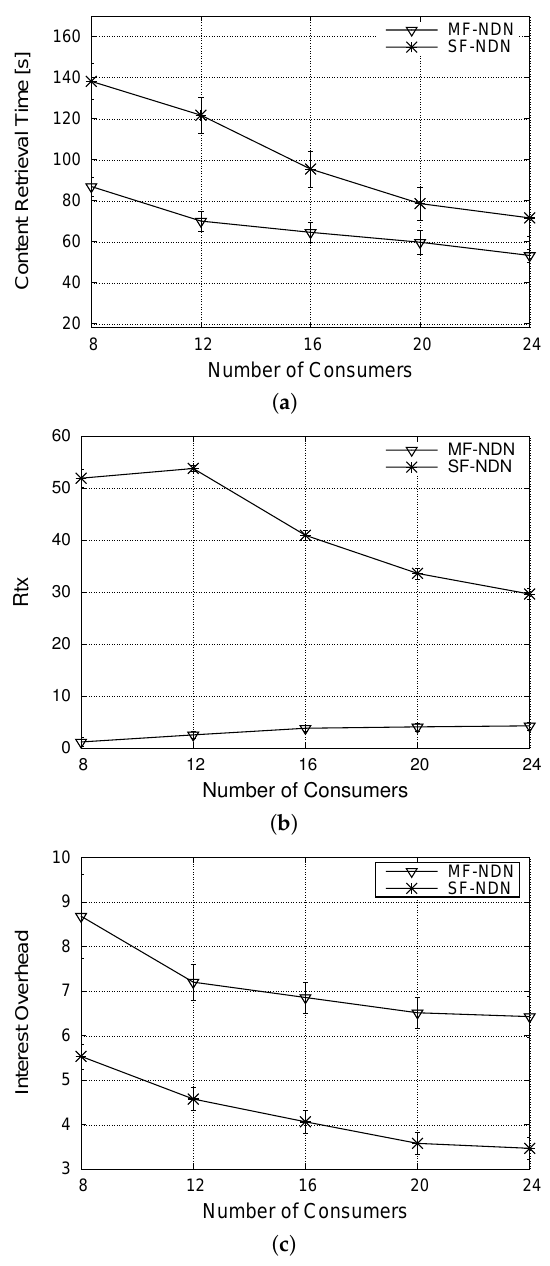
Figure 7. Metrics vs. number of consumers for the non-prioritized NDN schemes. ( a ) Content retrieval time; ( b ) Interest retransmissions; ( c ) Interest